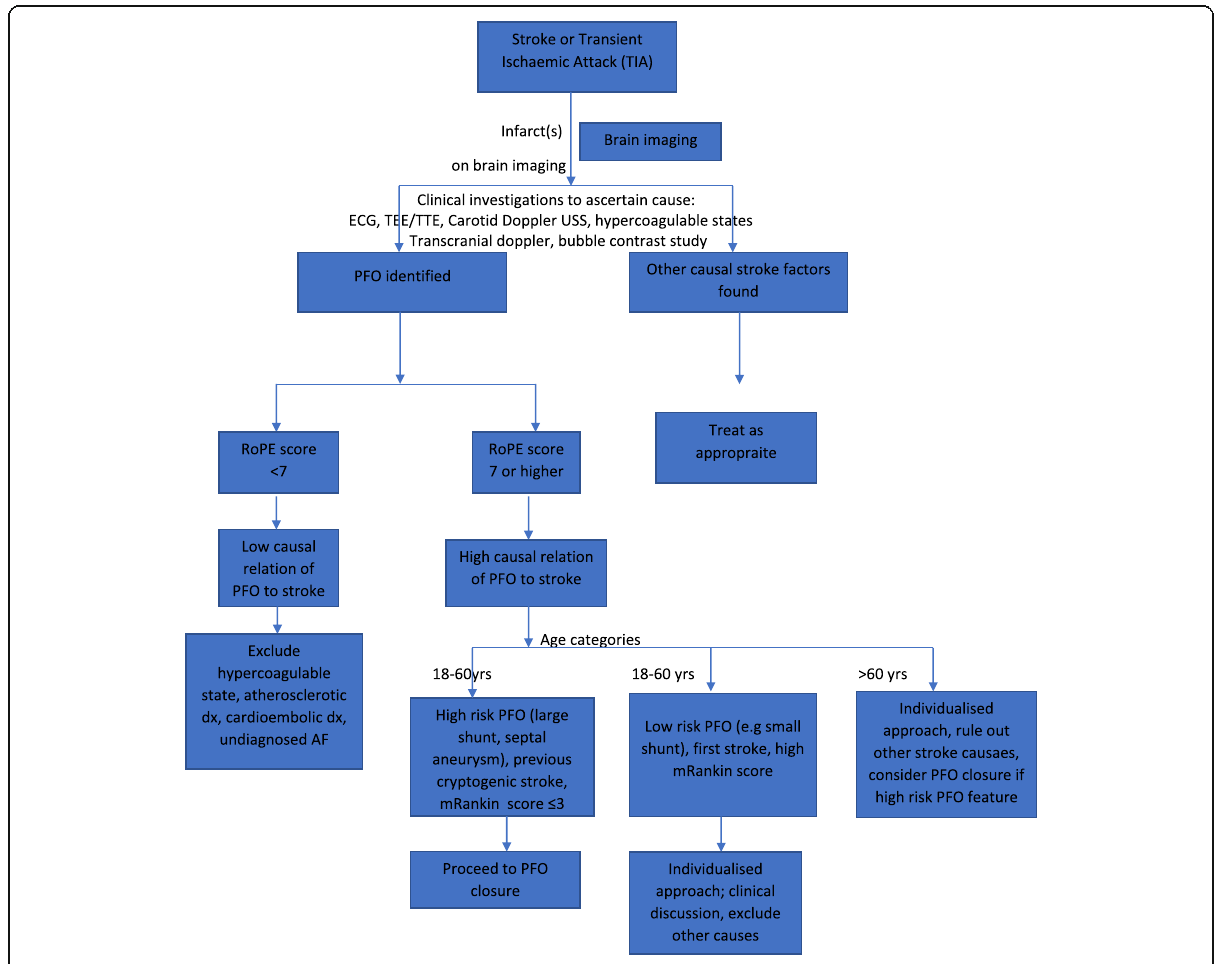
Fig. 1 Suggested algorithm for closure of PFO in individuals with cryptogenic